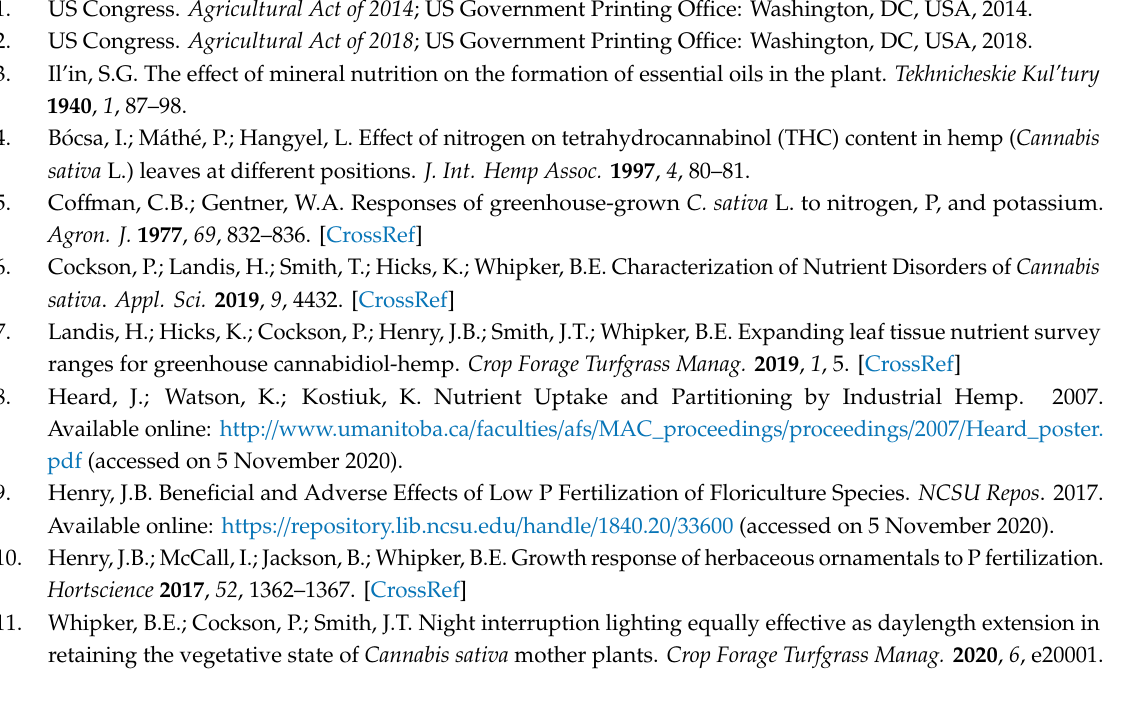
Figure S1: The terminal growing tip with four nodes (four blue circles) of a four-week-old vegetative C. sativa ‘BaOx’ plant. Figure S2: This two-week-old C. sativa ‘BaOx’ plant has been induced with long nights and is starting to develop reproductive structures. Figure S3: The eight-week-old C. sativa ‘BaOx’ plant terminal apical florescence is displaying changes in leaflet morphology. Figure S4: Eight-week-old reproductive secondary branch from a C. sativa ‘BaOx’ plant. Note how the internode length decreases (see black arrows) as the plant grows toward its branch